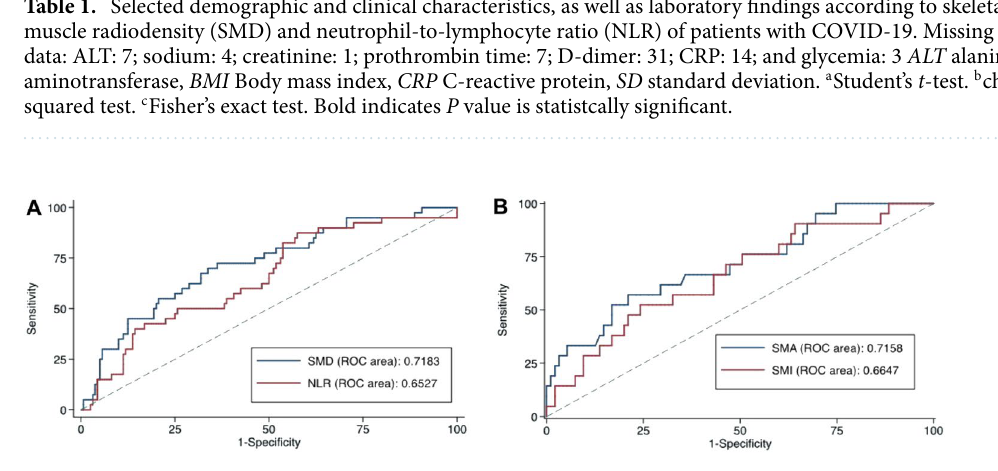
Figure 2. Youden index for ( A ) skeletal muscle radiodensity and neutrophil ‐ to ‐ lymphocyte ratio; and ( B ) skeletal muscle area and skeletal muscle index for patients with COVID-19. Abbreviations: SMA: Skeletal muscle area; SMD: Skeletal muscle radiodensity; SMI: Skeletal muscle index; NLR: Neutrophil-to-lymphocyte ratio; ROC: Receiver operating characteristic curve.